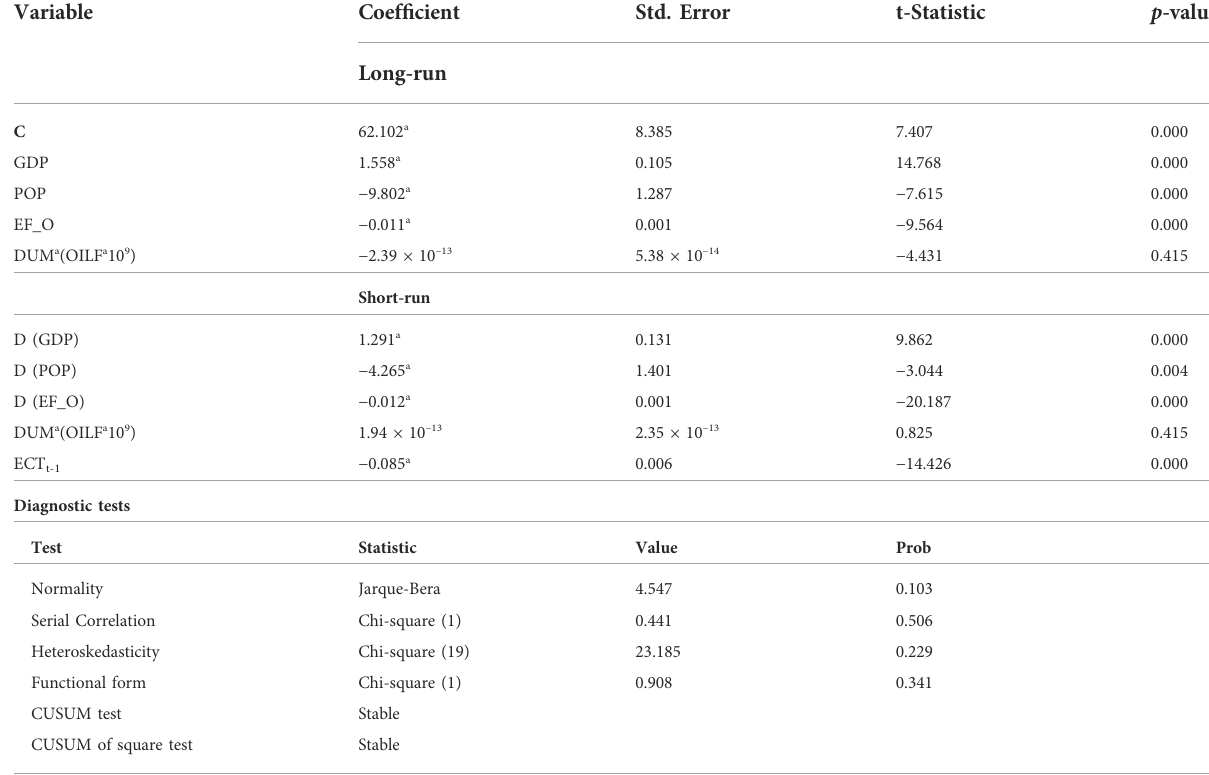
TABLE 12 ARDL results for the Oil power plant (dependent variable =